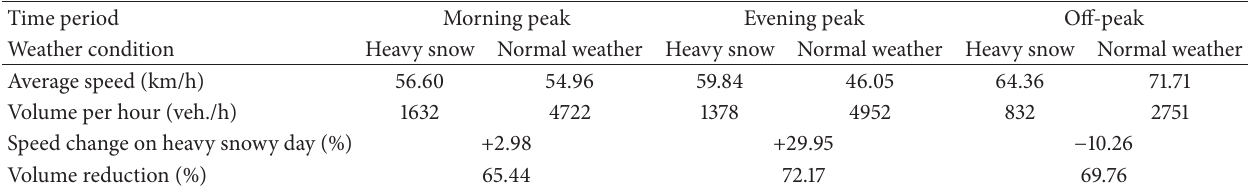
Table 2: Traffic flow characteristics of expressway under various weather conditions.